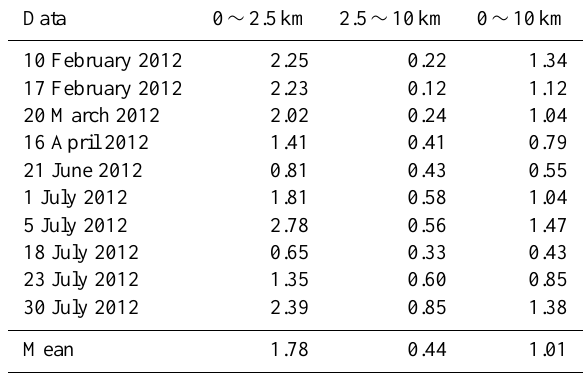
Table 5. RMS of differences between tomography-derived and radiosonde-derived water vapour densities (gm − 3 )